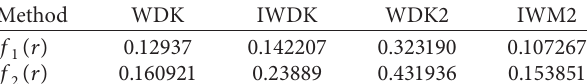
Table 1: Elapsed time in